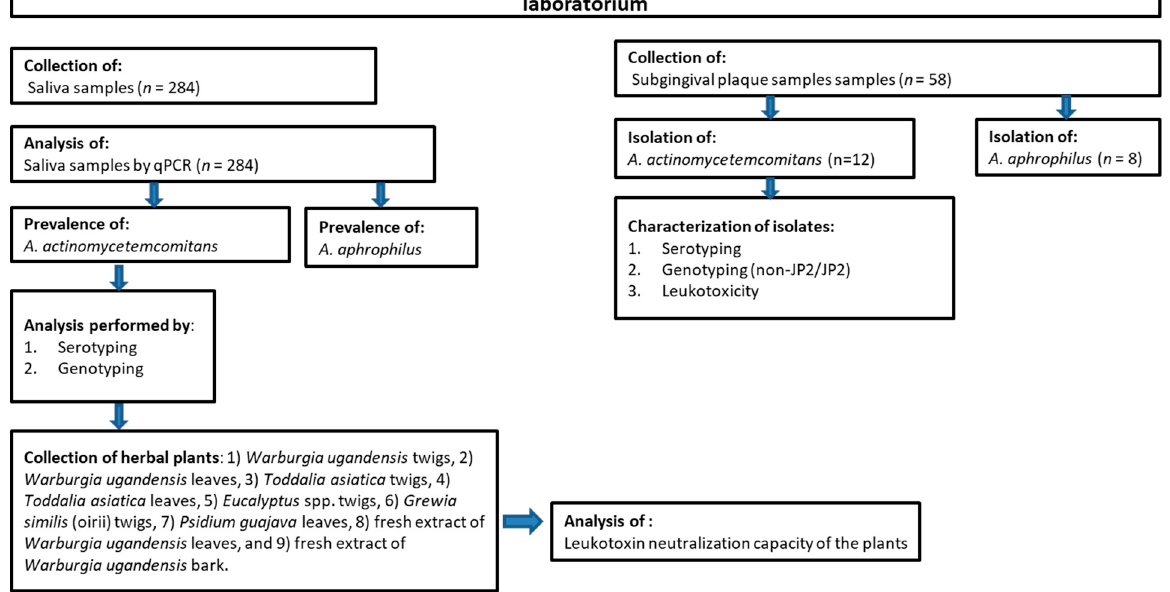
Figure 1. Flowchart describing the outline of the present work, assessing an adolescent population in Mara North Conservancy, Kenya ( n = 284).